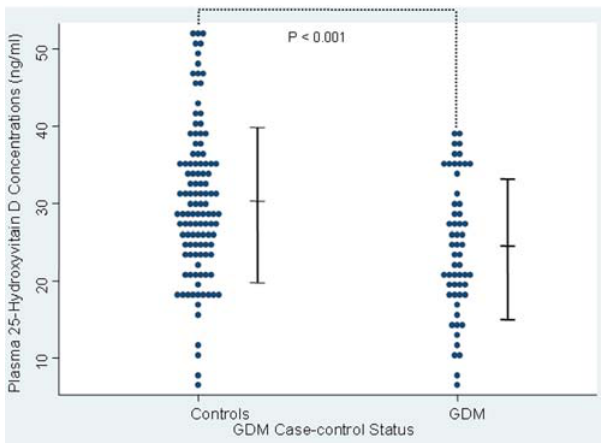
Figure 1. Maternal plasma 25-Hydroxyvitamin D concentra- tions in pregnancy among 57 GDM cases and 114 controls. Vertical bars indicate means 6 SD (standard deviation).